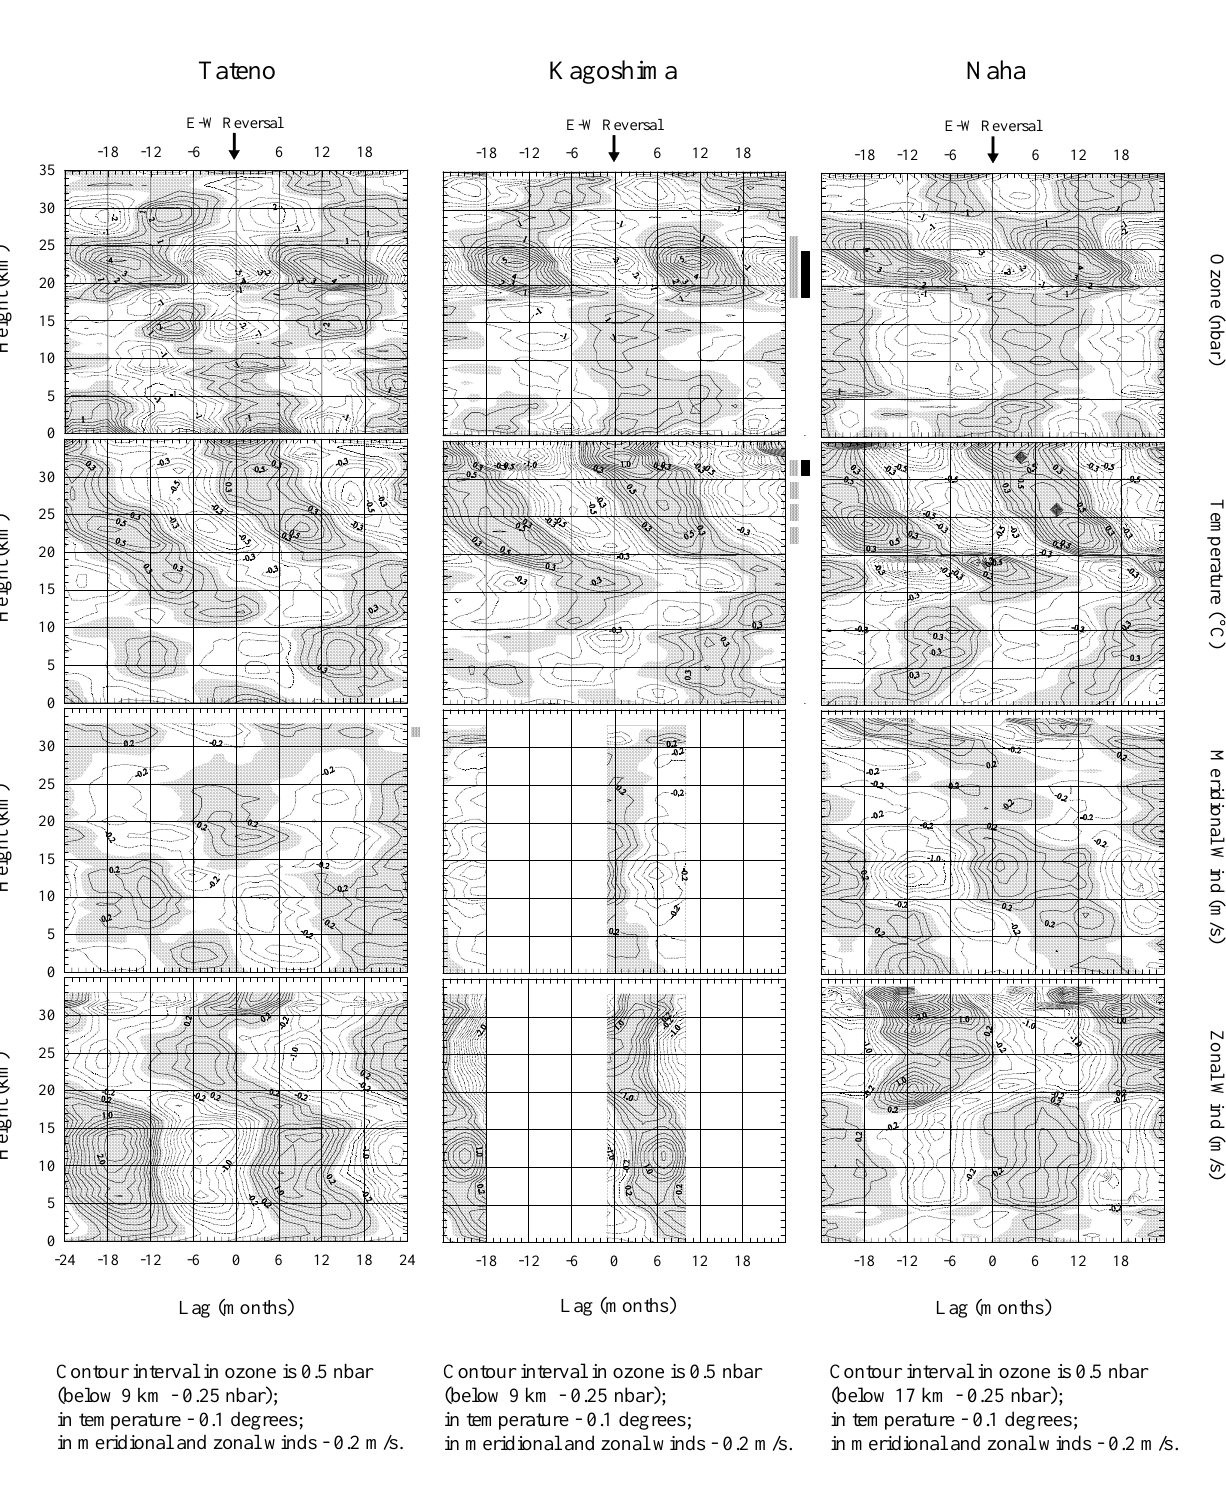
Lag (months) Contour interval in ozone is 0.5 nbar Contour interval in ozone is 0.5 nbar (below 9 km - 0.25 nbar); (below 9 km - 0.25 nbar); in temperature - 0.1 degrees; in temperature - 0.1 degrees; in meridional and zonal winds - 0.2 in meridional and zonal winds - 0.2 m/s.